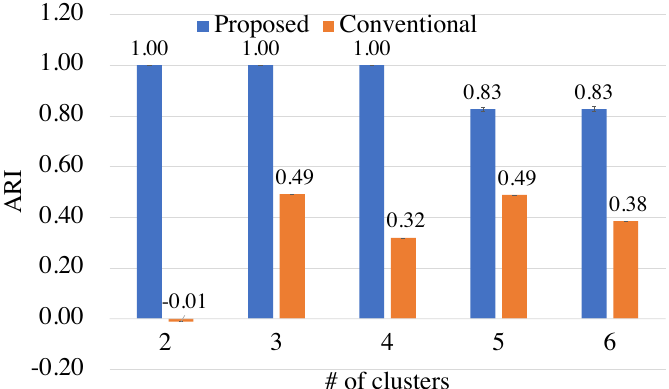
Figure 7. The qualities of the proposed kernel-based and conventional Euclidean-based methods for different numbers of